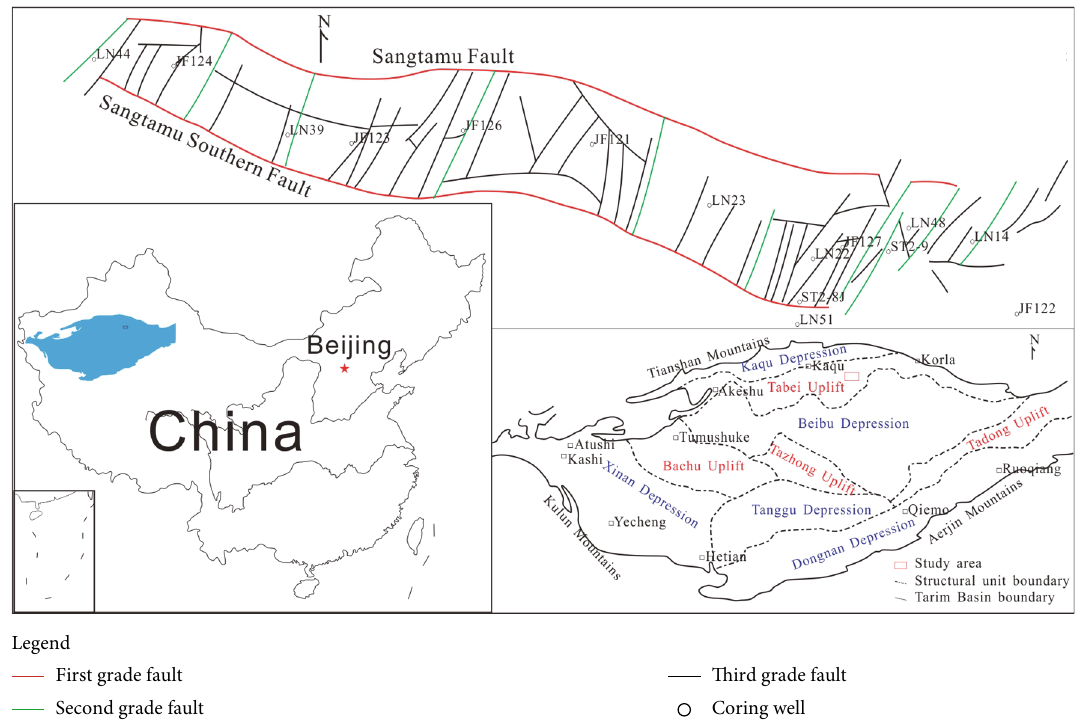
Figure 1: Location and structure diagram of Sangtamu Oil fi